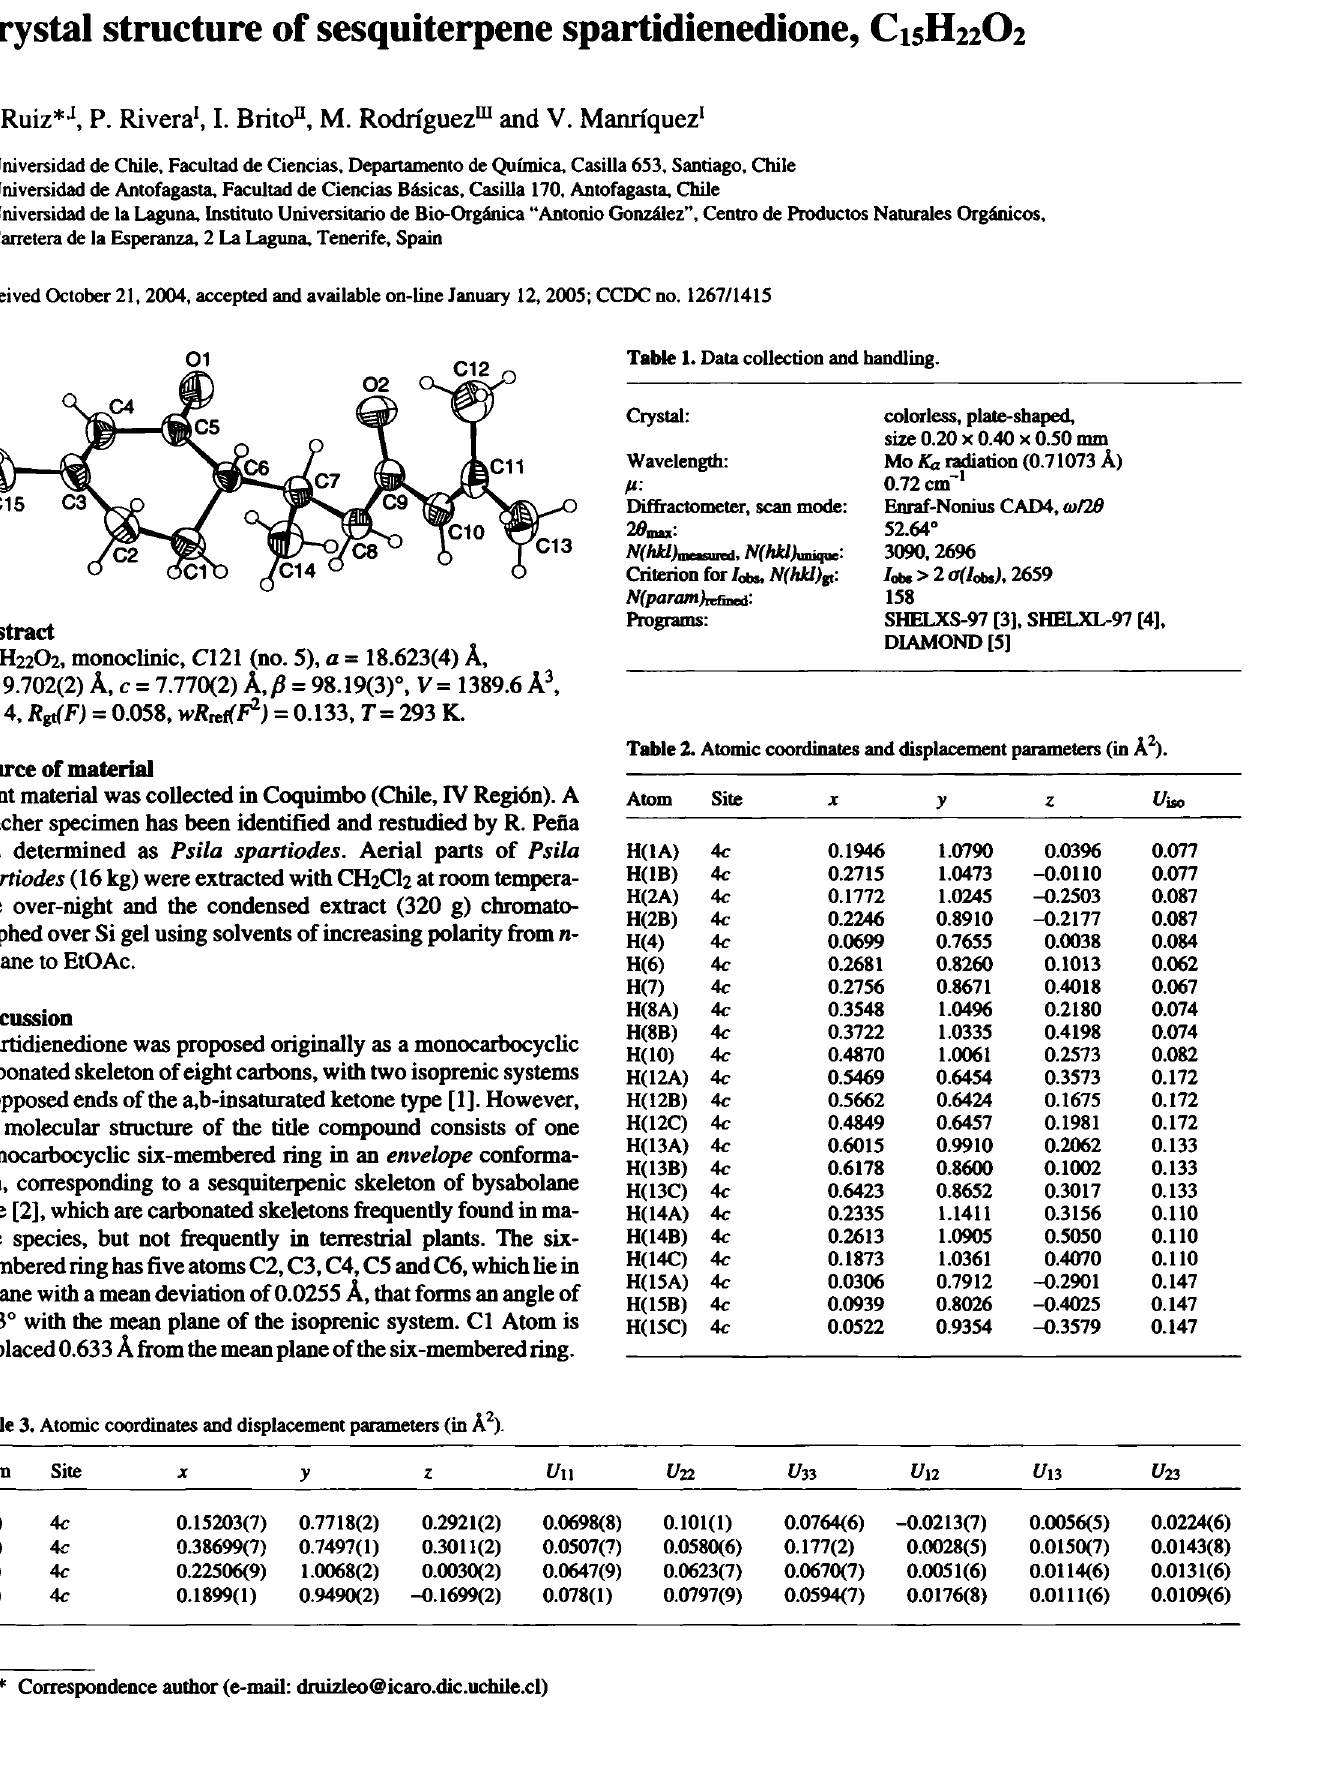
Table 1. Data collection and handling.